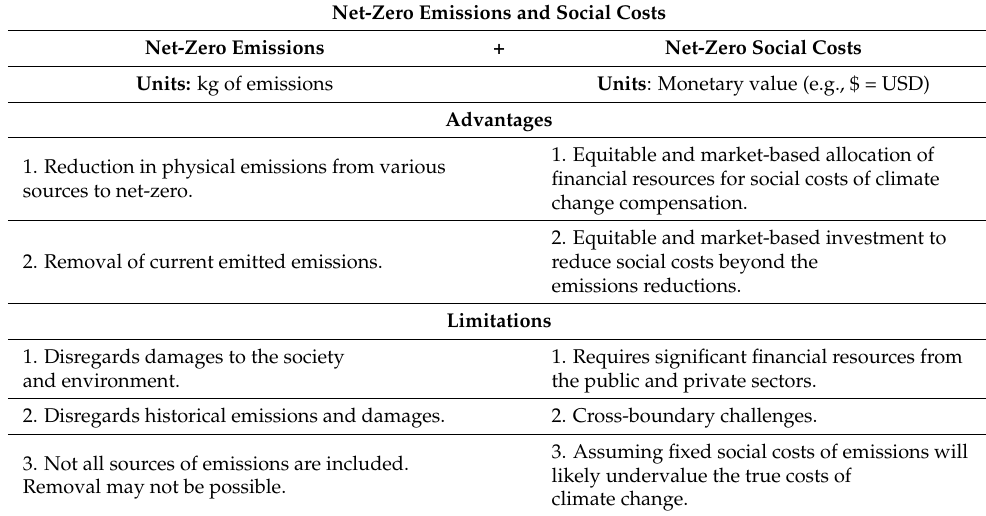
Table 12. The newly proposed addition of net-zero social costs to the concept of net-zero